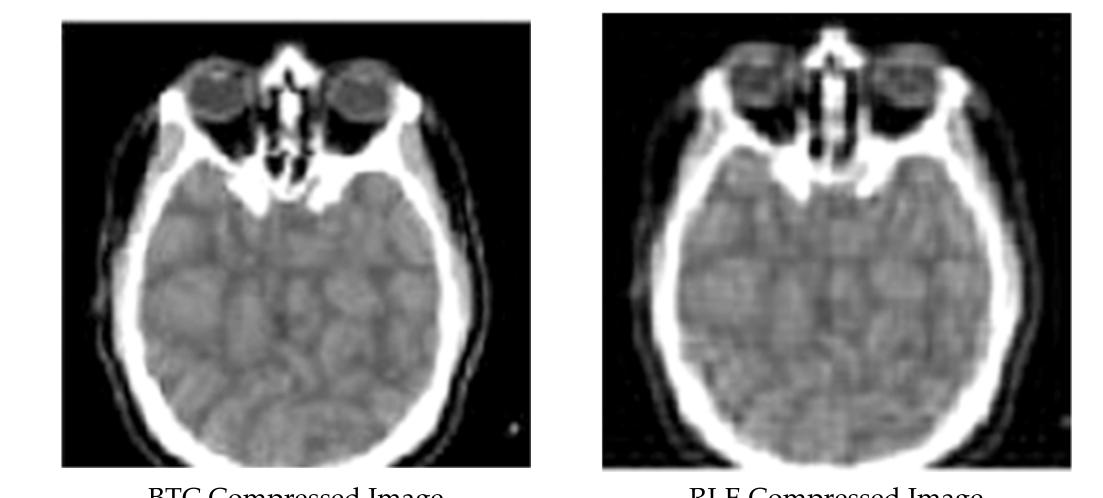
Figure 3. Lossless techniques: Lossless compression utilizing RLE and BTC.